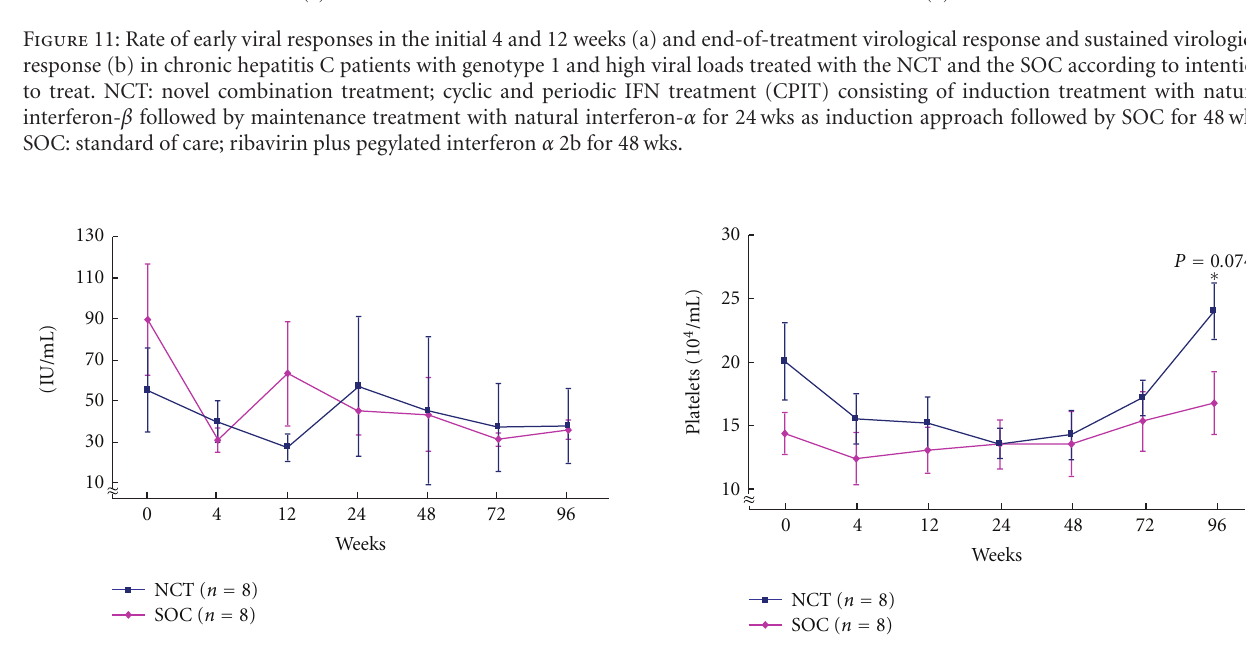
Figure 13: Changes in platelets level of peripheral blood during the NCT and the SOC in chronic hepatitis C patients with genotype 1 and high viral loads. NCT: novel combination treatment; cyclic and periodic IFN treatment (CPIT) consisting of induction treatment with natural interferon- β followed by maintenance treatment with natural interferon- α for 24 wks as induction approach followed by SOC for 48 wks. SOC: standard of care; ribavirin plus pegylated interferon α 2b for 48